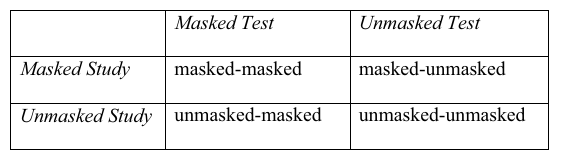
Fig. 4 A depiction of the within‑participants conditions used in Experiment 2. Note . For each of these conditions, hits and false